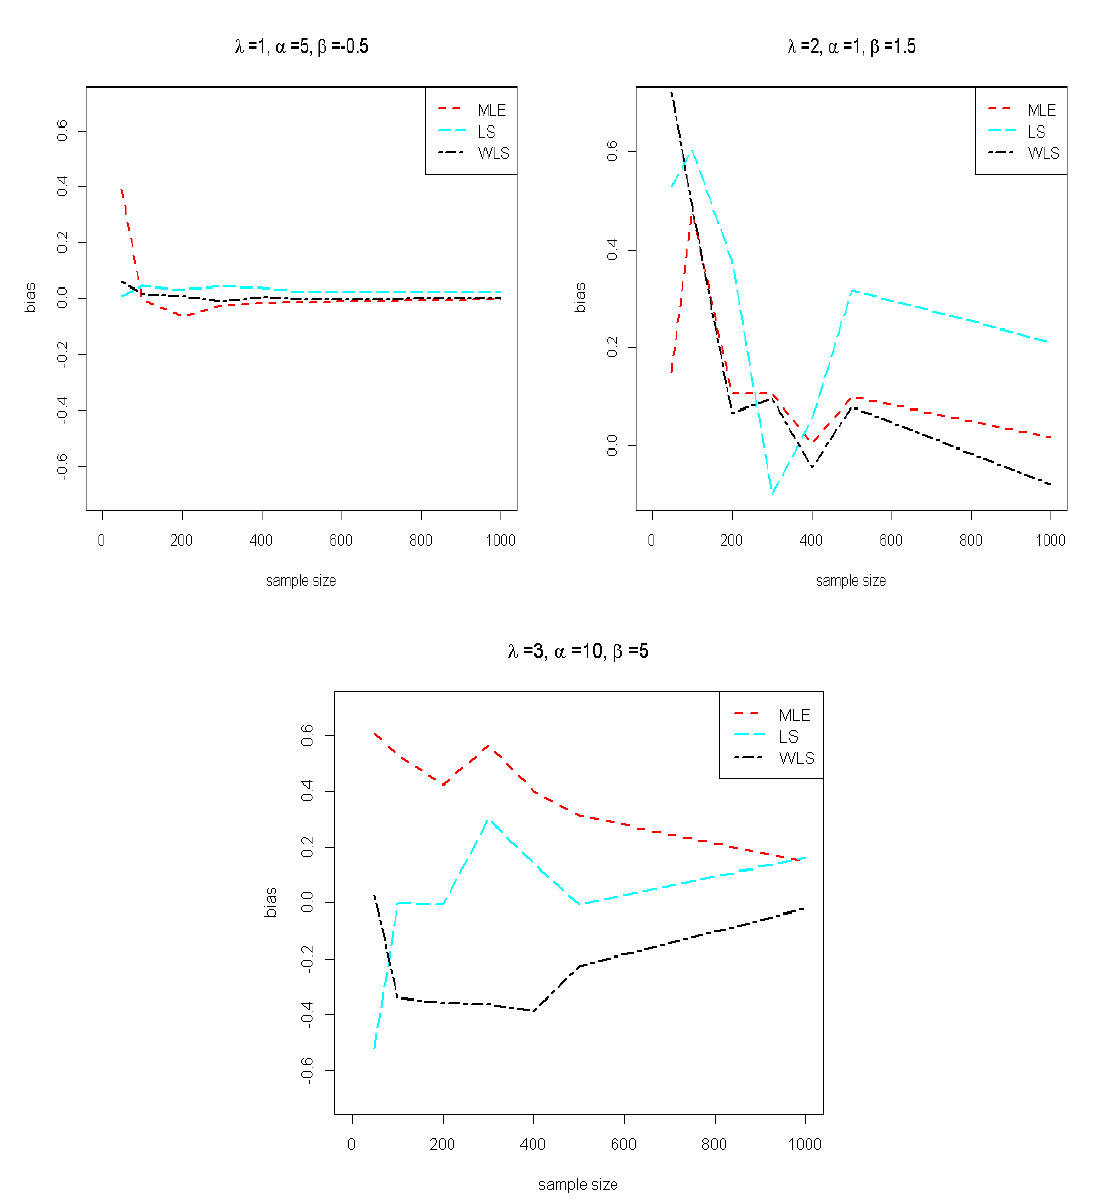
Figure 5. Bias of estimator ˆ β versus sample size n for different